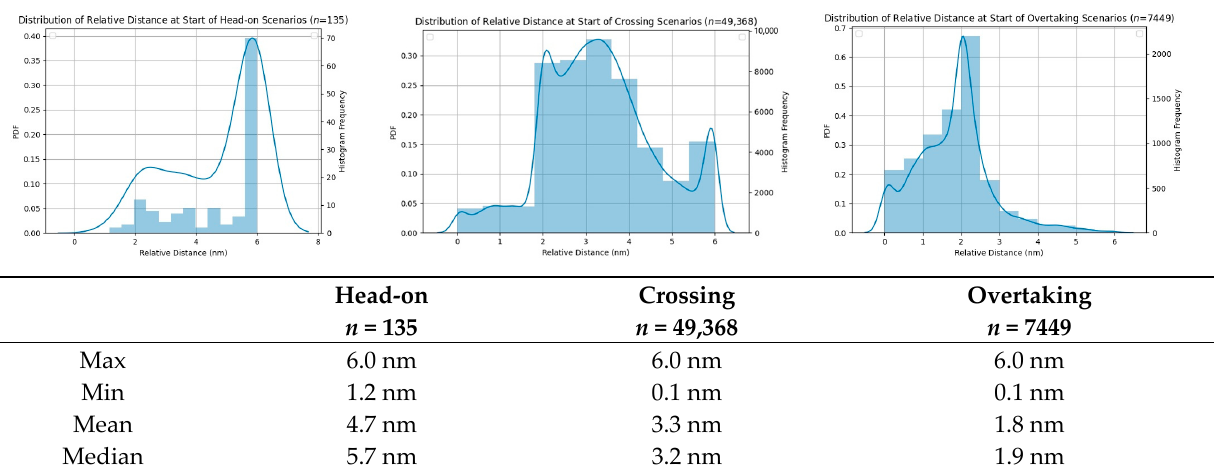
3.2 kn Figure 7. Distribution of relative speed at the start of different encounter scenarios. The numbers indicate the approach speed of OS and TS at the encounter situation being initiated. Figure 8 presents the empirical distribution of duration time for different encounter scenarios. The average duration time is different in different encounter types. The crossing scenarios on average have a lower duration time (6.8 min) than head-on scenarios (12.6 min), which again, on average, have a lower duration time than overtaking scenarios (20.6 min); even the max duration time of overtaking scenarios reaches 115 min. In other words, the testing of one overtaking scenario will cost much more time.